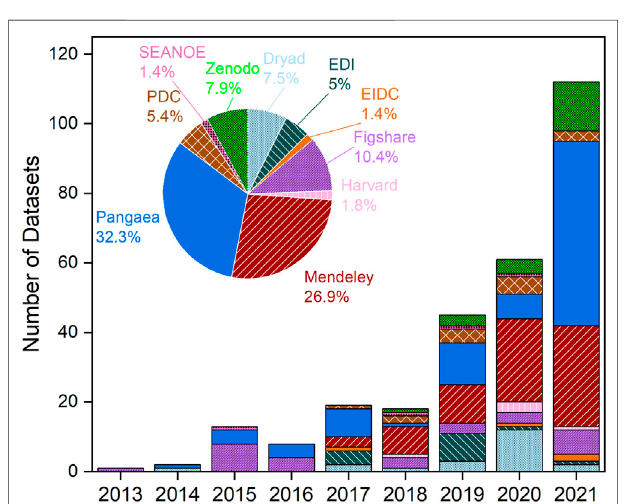
FIGURE 5 | Geographical distribution of microplastics datasets according to sample provenance. Note that the marine environments and estuaries section includes beaches, coastal areas, seas, and trenches. Unknownmeansthattherewerenotsuf fi cientmetadatainthedatasetto determine the